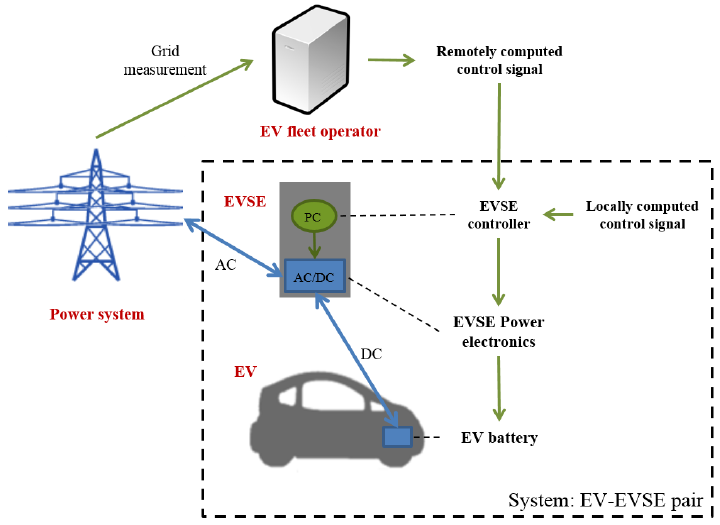
Figure 2. Test configuration for the local and the remote control